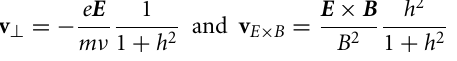
of a planar cathode; in this configuration the potential drop due to the applied voltage takes place in the plasma volume and not in a cathode sheath, leading to extraction and acceleration of the ions out of the device; many variations are possible depending on the position of the magnetic barrier and on the anode